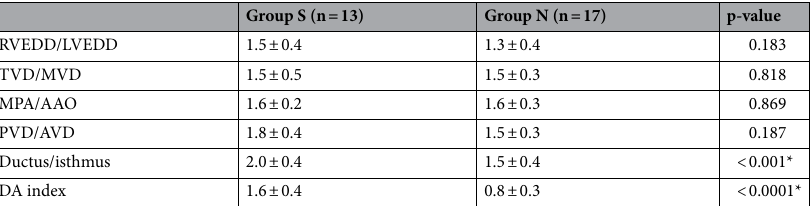
Table 3. Ratio of cardiac parameters and multiplier compared between groups. RVEDD right ventricular end- diastolic diameter, LVEDD left ventricular end-diastolic diameter, TVD tricuspid valve diameter, MVD mitral